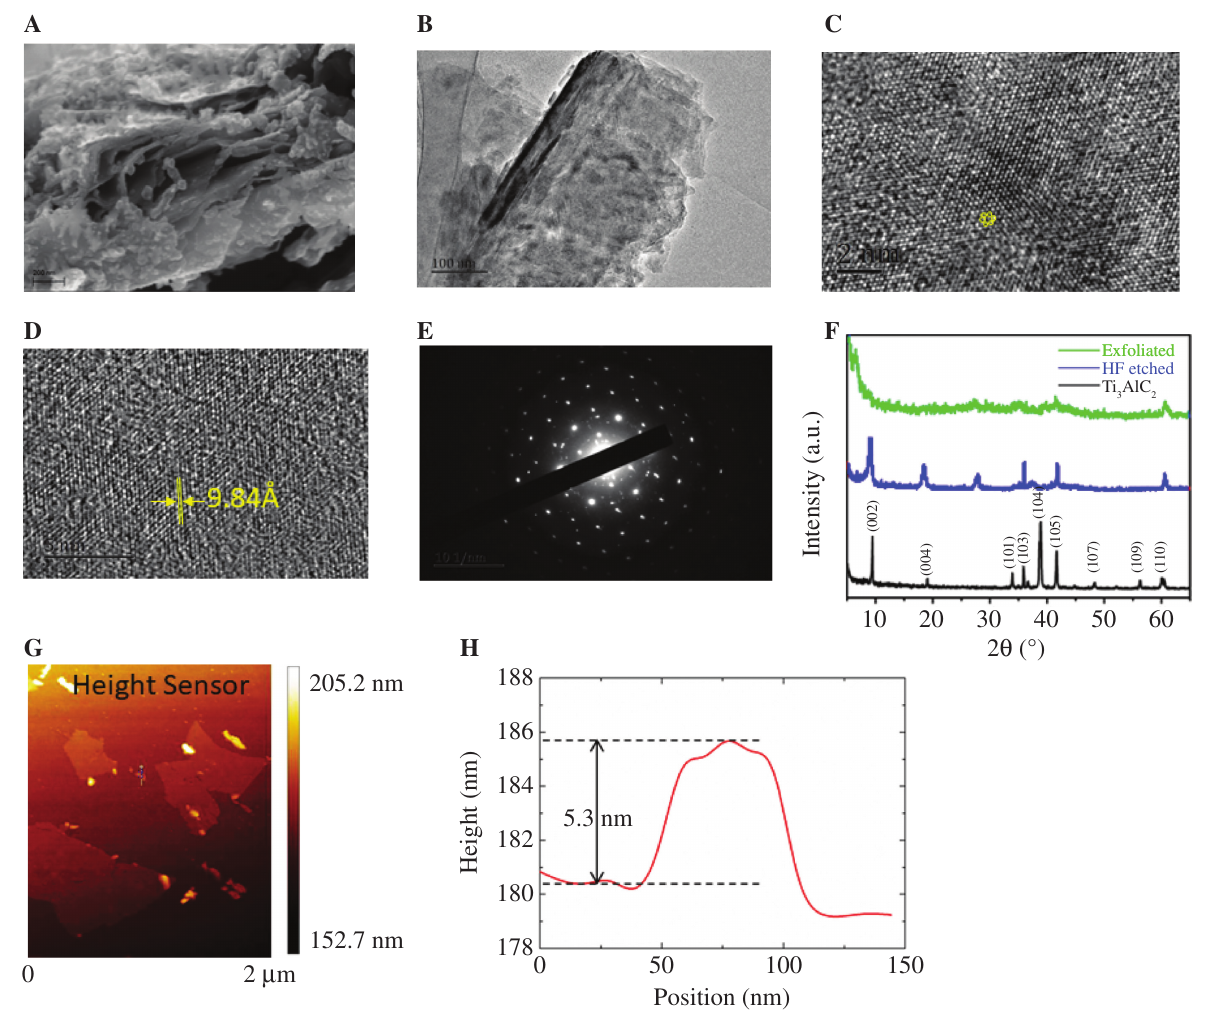
C T nanosheets. 3 2 x C T after HF etching; (B) typical TEM image of exfoliated few-layer Ti 3 2 x